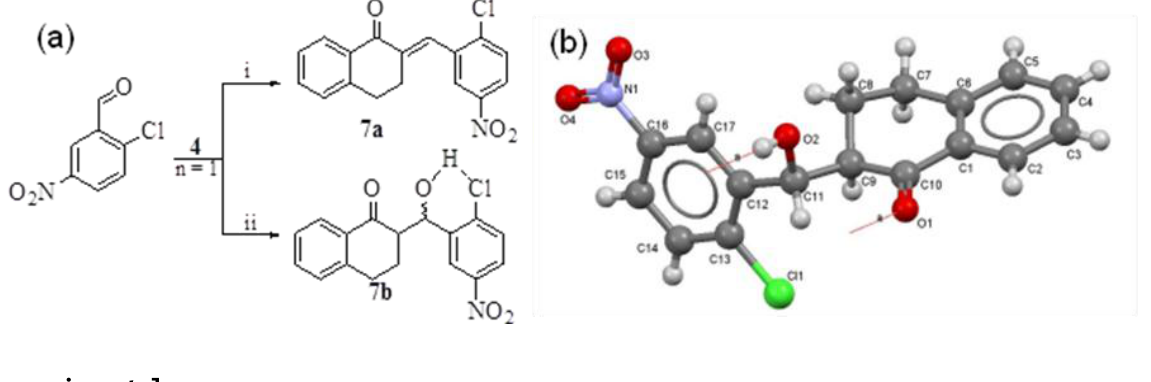
SO reflux ( 7b , 73%). ( b ) The 2 4